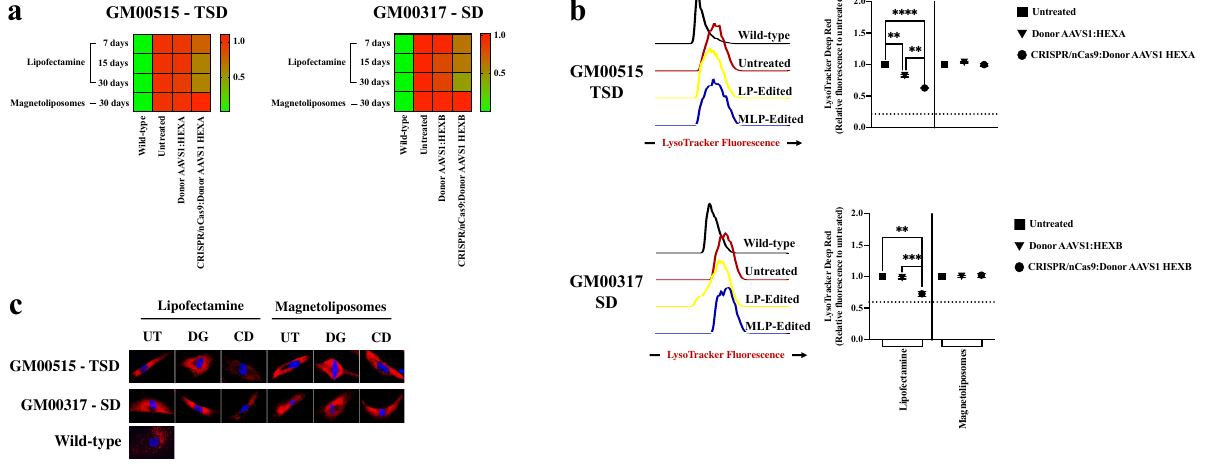
Figure 6. GAGs and lysosomal mass determination on long-term edited GM2 fibrob- lasts. ( a ) A heat map shows the changes in the GAGs accumulation in both GM00515-TSD and GM00317-SD fibroblasts after one month of treatment ( n = 4). ( b ) Lysosomal mass was quanti- fied by flow cytometry. The left panel shows a representative histogram for each experimental group. The right panel shows the mean of four independent experiments. ( c ) Epifluorescence microscopy images at 60 × for GM00515-TSD and GM00317-SD fibroblasts stained for lysosomal mass analysis. Blue fluorescence is for the nuclei. UT: Untreated. DG: Donor AAVS1:GOI, CD: CRISPR/nCas9 plus Donor AAVS1:GOI. ** p ≤ 0.01, *** p ≤ 0.001, **** p ≤ 0.0001. Two-tailed Student’s t